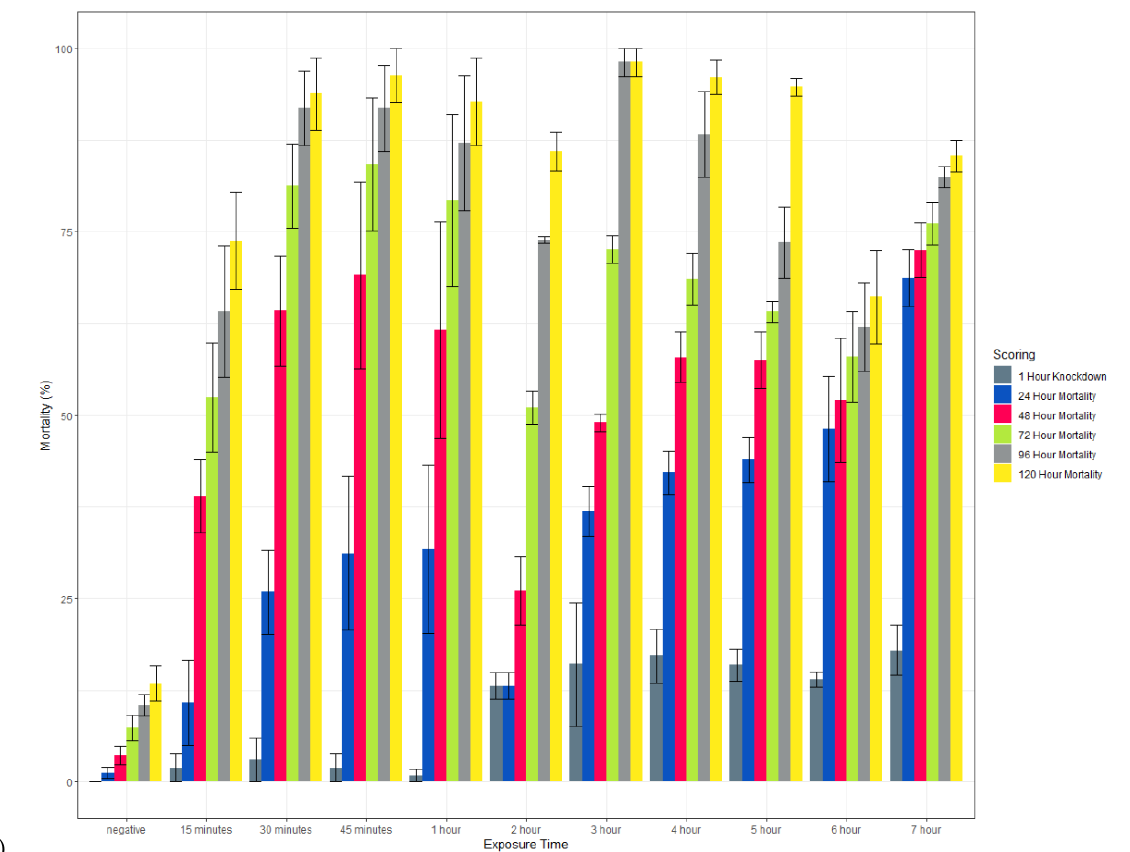
Figure 8. Effect of the length of exposure to SumiShield TM 50WG in a WHO susceptibility tube test against susceptible (New Orleans) ( A ) and resistant (Cayman) ( B ) strains of Ae. aegypti and a susceptible strain of An. gambiae ( Kisumu) ( C ). Mosquitoes were exposed for varying lengths of time to filter papers treated with 13.2 or 733.3 mg AI/m 2 of clothianidin. Error bars represent standard error between 3 replicate tubes of ~25 females per tube.